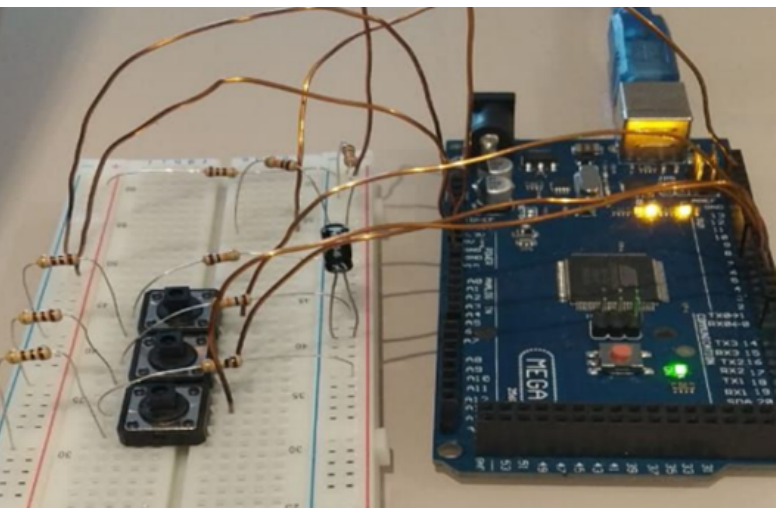
Figure 12. Low-cost smart meter prototype with Arduino Mega proposed in scientific